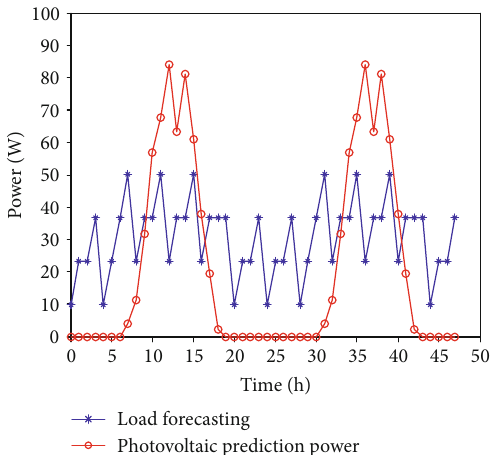
Figure 5: PV and load output power forecasting.